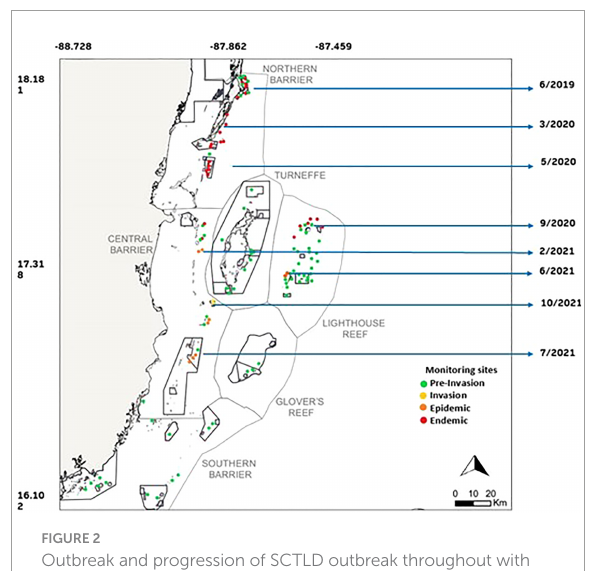
FIGURE 2 Outbreak and progression of SCTLD outbreak throughout with the first known record June